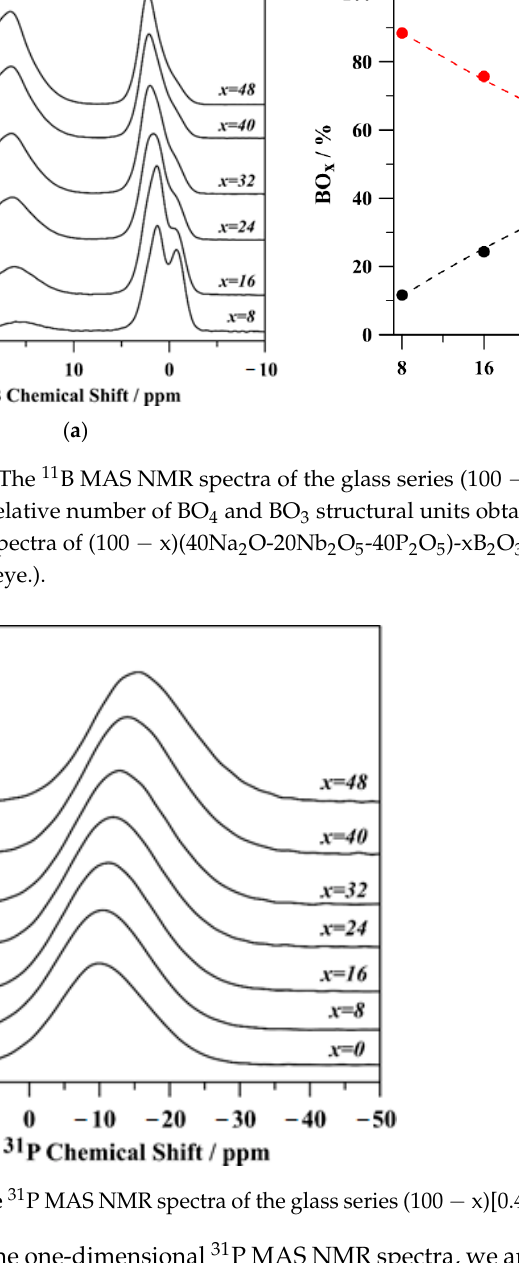
Figure 7. XRD patterns of crystallized samples of the (100 − x)[0.4Na 2 O-0.2Nb 2 O 5 -0.4P 2 O 5 ]-xB 2 O 3 glasses.